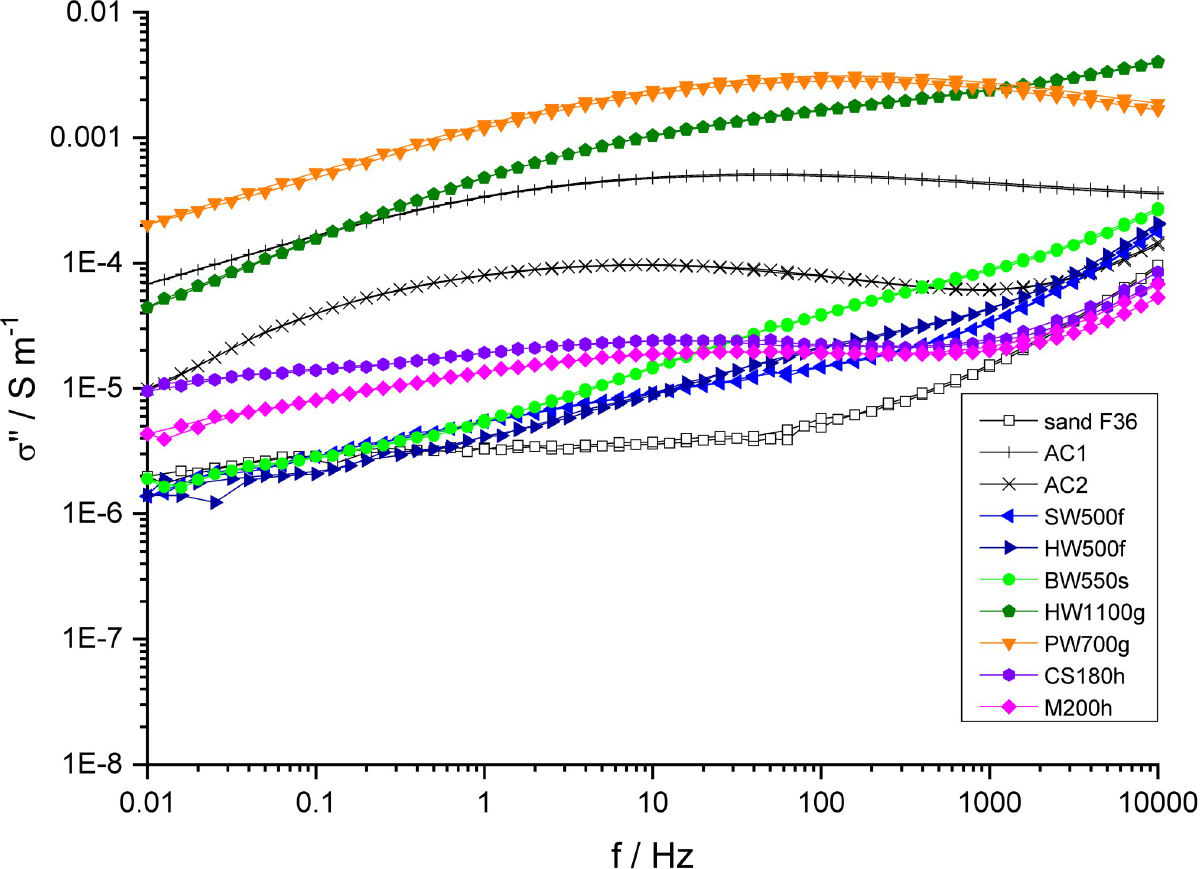
Fig 10. Imaginary part of the complex electrical conductivity of 2% mixtures of the chars with sand saturated with 4 mM